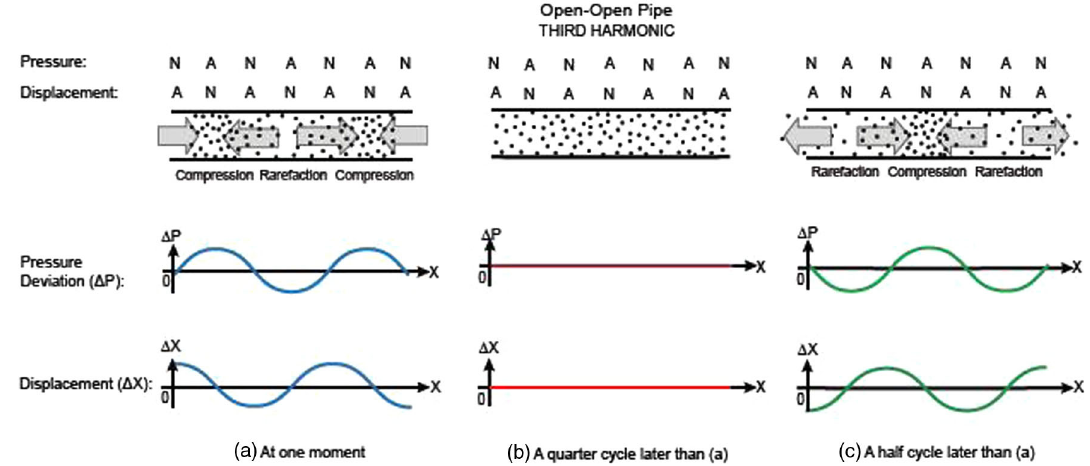
FIG. 11. Third harmonic sound standing wave in an open-open